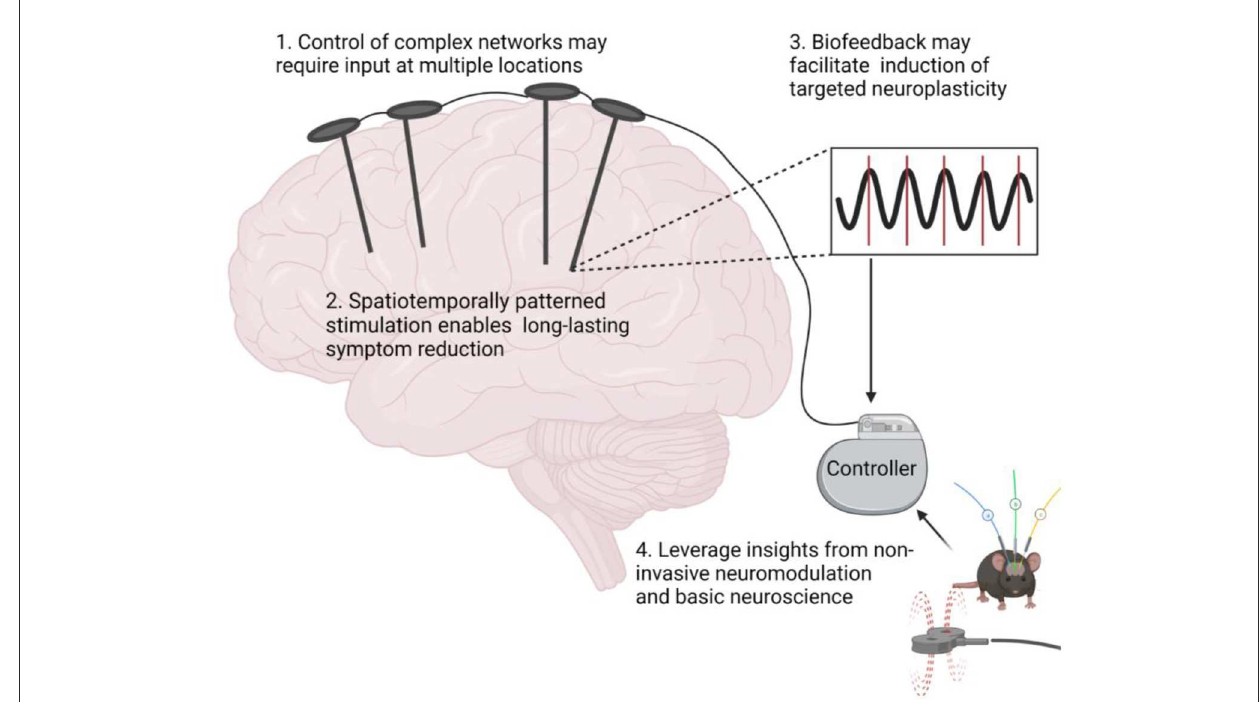
FIGURE1 Targeted neuroplasticity approaches for invasive neuromodulation therapies. Figure created with